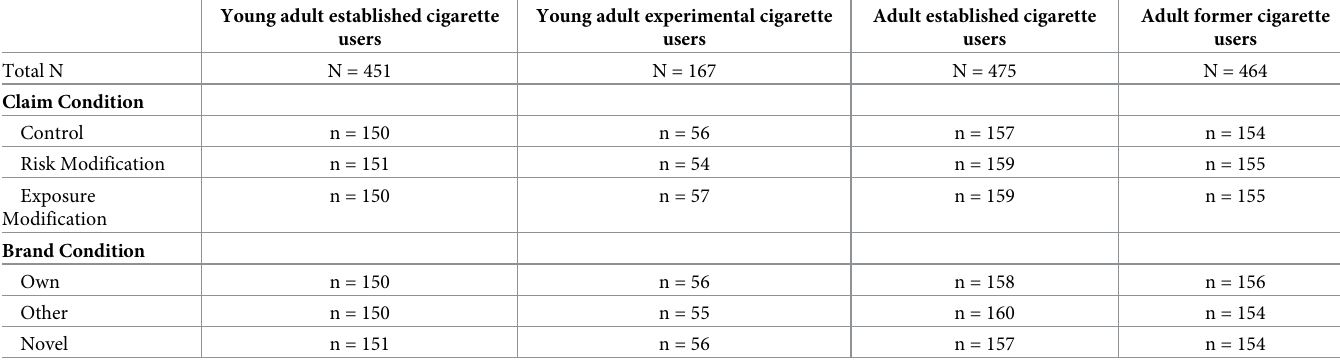
Table 2. Sample size by claim and brand